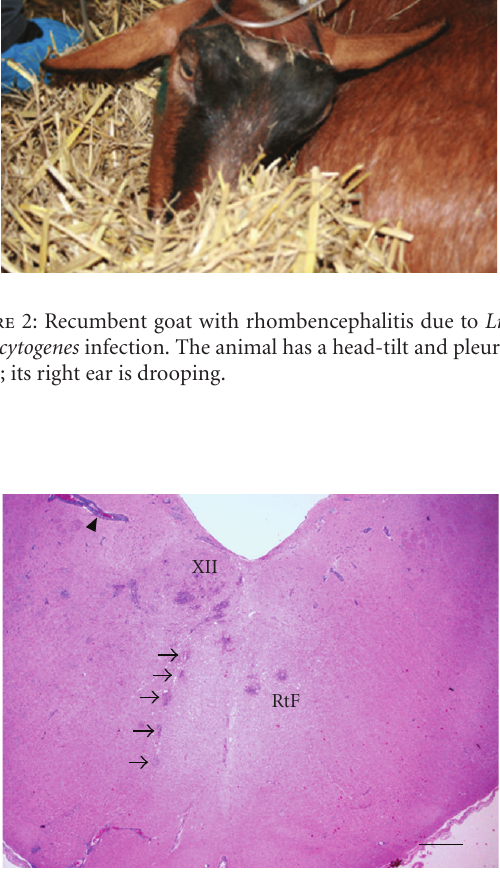
Figure 3: Rhombencephalitis in a sheep: Brainstem at the obex region with multiple microabscesses and perivascular cu ffi ng (arrowhead). Microabscesses involve the hypoglossal nucleus (XII), its intracerebral root (arrows), and the reticular formation (RtF). Hematoxylin & Eosin stain (H&E), bar = 740 μ m.